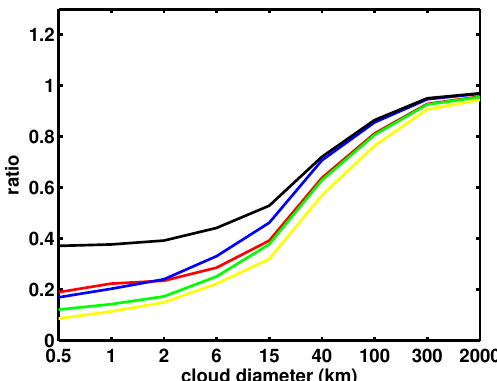
/R cloud for differ- col col